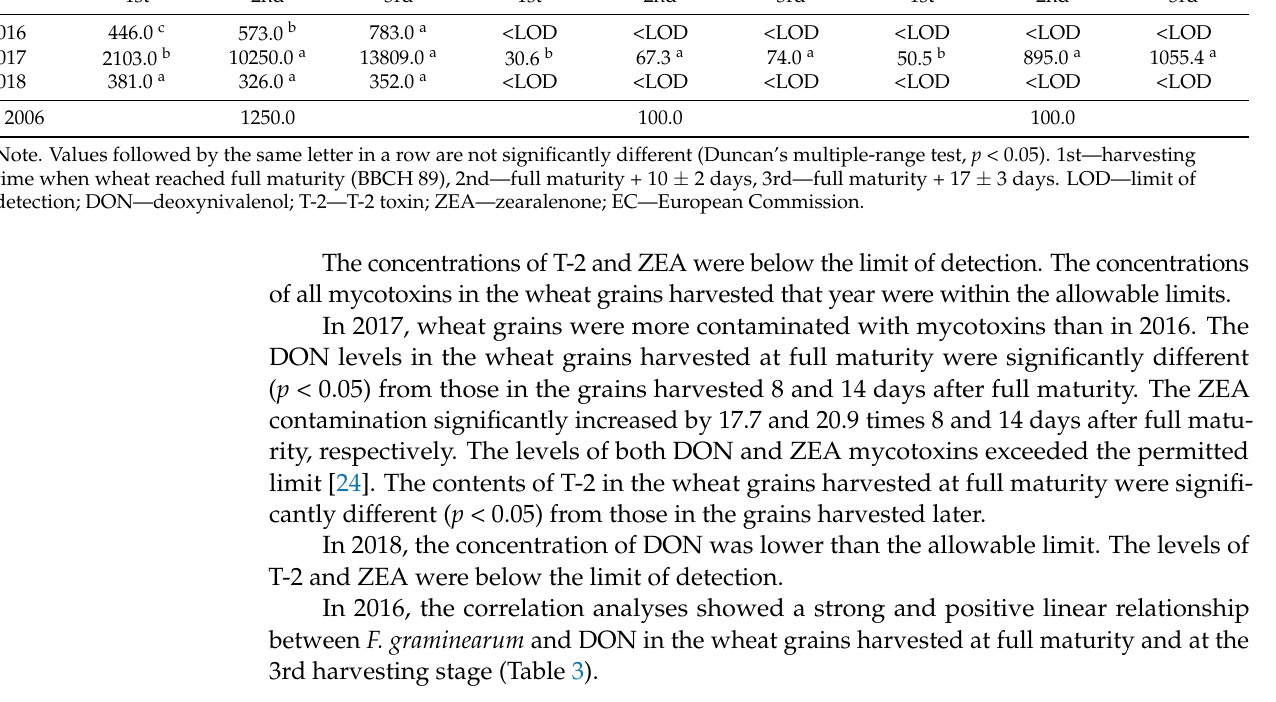
Table 2. Mycotoxin contamination of spring wheat grain at different harvest times during the 2016–2018 growing seasons. DON ( µ g kg − 1 ) T-2 ( µ g kg − 1 ) ZEA ( µ g kg − 1 ) Years Harvesting Time Harvesting Time Harvesting Time 2nd 3rd